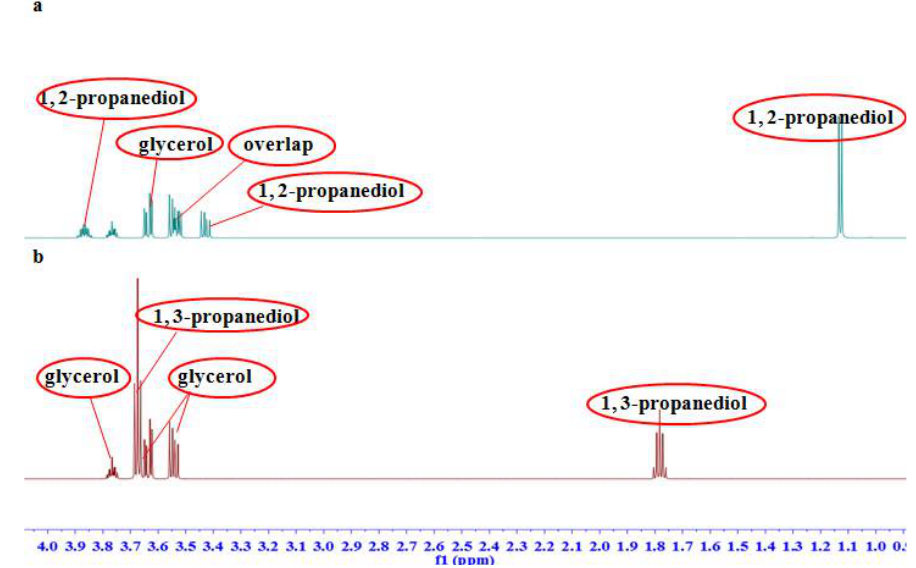
Figure 2. 1 H NMR spectra of ( a ) glycerol and 1,2-propanediol mixture and ( b ) glycerol and 1,3-propanediol mixture.